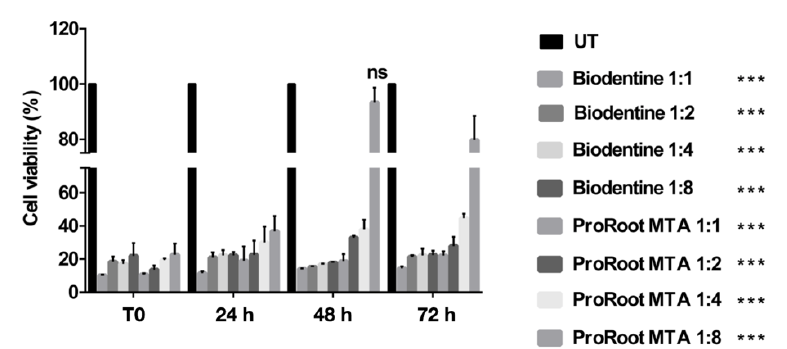
Figure 2. Analysis of cell viability, measured by the thiazolyl blue tetrazolium bromide (MTT) assay, of Saos-2 cells grown to serial dilution of Biodentine and Pro Root MTA extracts at 24, 48, and 72 h. Data are expressed as mean ± SD. Statistical analysis was performed by the two-way analysis of variance (ANOVA) method coupled with the Bonferroni post-test (*** p < 0.001 compared to the untreated sample